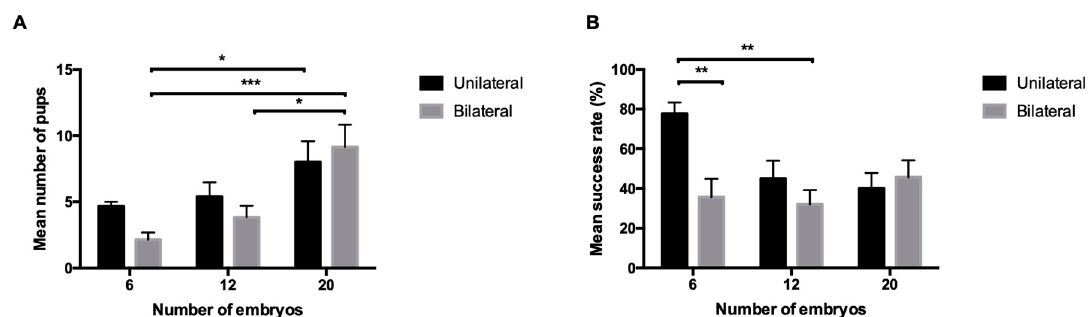
Figure 2. ( A ) Mean number of pups after unilateral and bilateral transfers using 6, 12 and 20 C57BL/6J embryos. Statistically significant differences were found between 6 embryos unilateral group and 6 and 12 embryos bilateral; ( B ) success rates for unilateral and bilateral transfers using 6, 12 and 20 embryos. Statistically significant differences were found between 6 embryos bilateral and 20 embryos unilateral and bilateral and between 12 and 20 embryos bilateral. Values are mean ± SEM. * p < 0.05, ** p < 0.01, *** p < 0.001. Table 3. Embryo e ff ort for the generation of one live pup using C57BL / 6J and B6129F1. Reciprocity